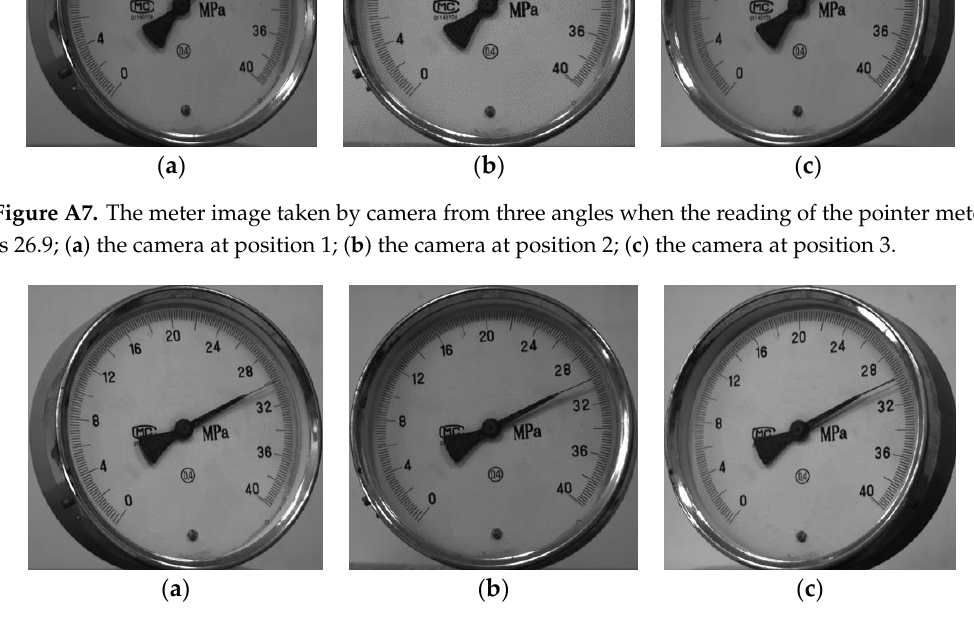
Figure A8. The meter image taken by camera from three angles when the reading of the pointer meter is 30.2; ( a ) the camera at position 1; ( b ) the camera at position 2; ( c ) the camera at position 3.